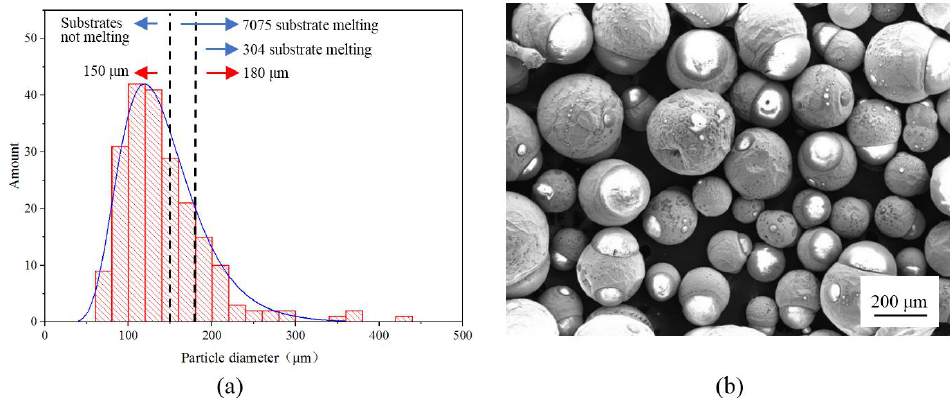
Figure 9. Particle size distribution and morphology: ( a ) Particle size distribution, ( b ) Particle morphology.